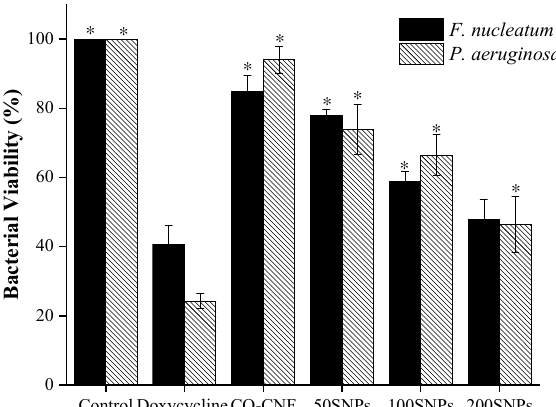
Figure 4. Effects of nanoparticles on the metabolic activity of Fusobacterium nucleatum and Pseudo- monas aeruginosa . Data are expressed as mean ± S.D. ( n = 3). The asterisk (*) represent significant differences ( p < 0.05) from positive control (doxycycline) analyzed by Tukey’s test. CO-CNF: κ - carrageenan oligosaccharides linked cellulose nanofibers; 50SNPs: 50 mg surfactin-loaded CO-